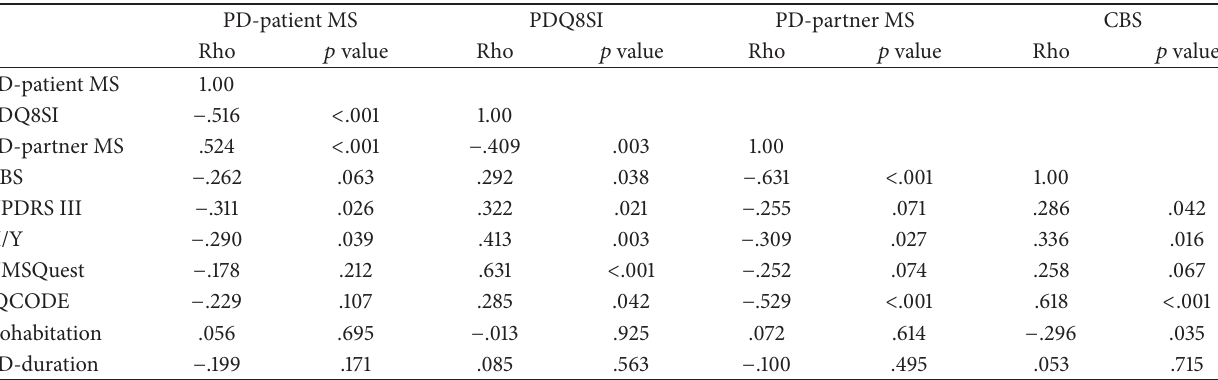
Table 4: Spearman rank correlation coefficients between independent variables and dependent variables. 𝑛 = 51 dyads. PD-patient MS